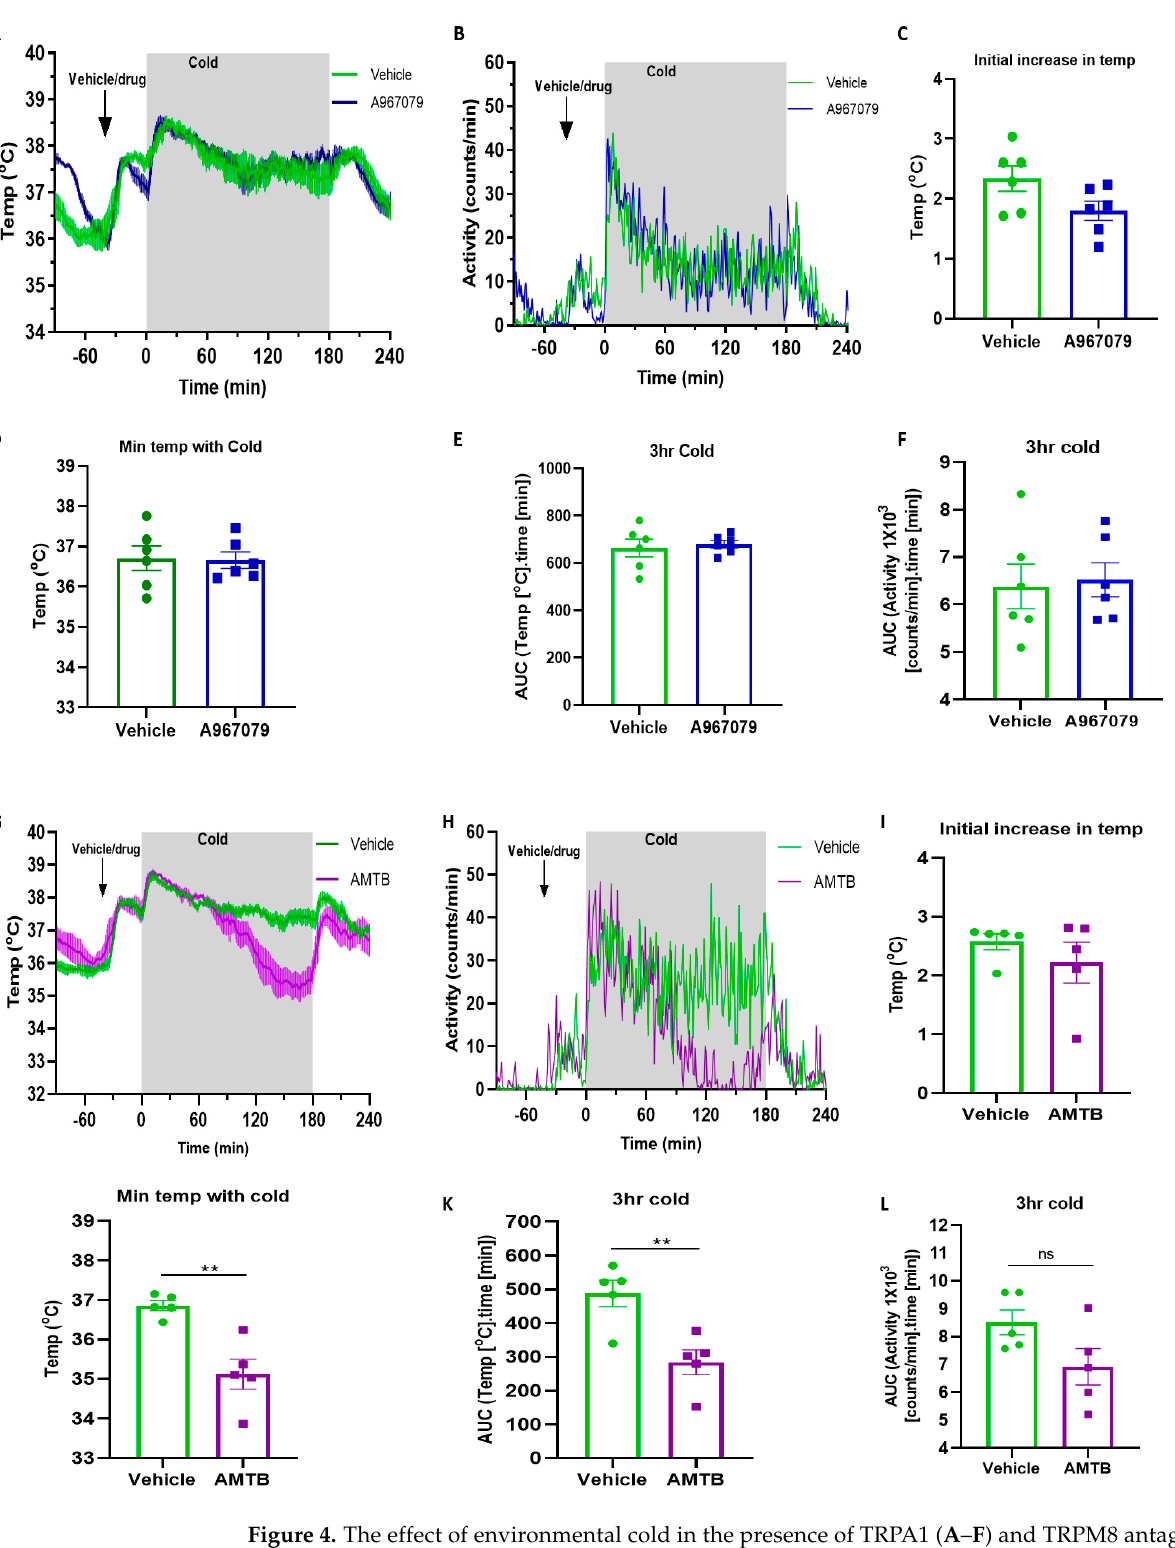
Figure 4. The effect of environmental cold in the presence of TRPA1 ( A – F ) and TRPM8 antagonist ( G – L ) in C57BL/6. The graphs represent ( A ) the mean core body temperature and ( B ) the mean activity changes during 3 h of cold (4 °C) exposure in a climatic chamber in the presence of TRPA1 antagonist A967079 (100 mg/kg) that was given orally 30 min prior to the cold treatment ( n = 6). ( C ) The initial temperature increase at the start of cold exposure in the climatic chamber; ( D ) the minimum temperature achieved during 3 h of cold exposure; ( E ) the area under the curve (AUC) analysis of the temperature during the 3 h of cold treatment. ( F ) The area under the curve (AUC) analysis of